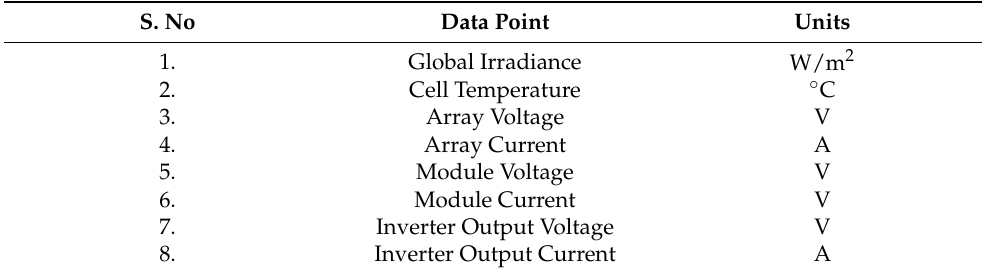
Figure 1. Block diagram of a system for converting solar energy into electricity with a monitoring system. Table 1. Measured climatic and electrical data